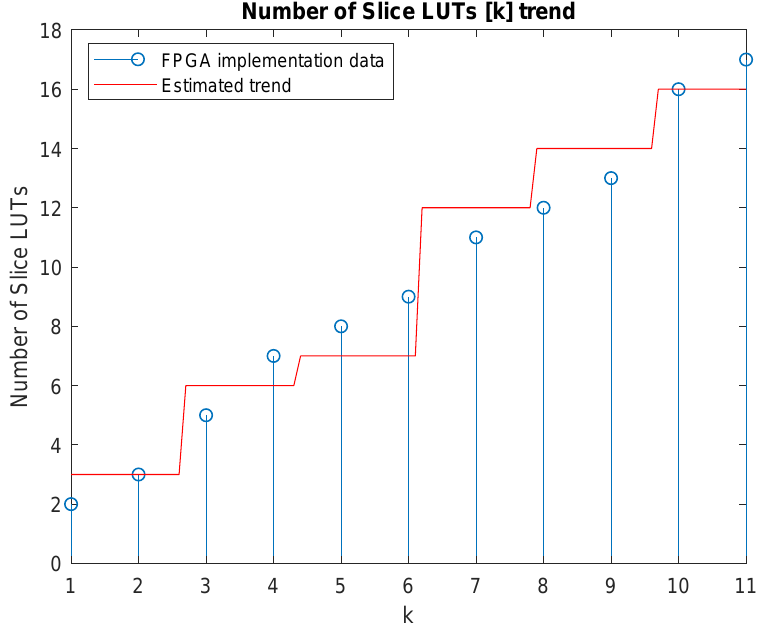
Figure 8. Estimated trend of the number of lookup tables (LUTs) as function of k